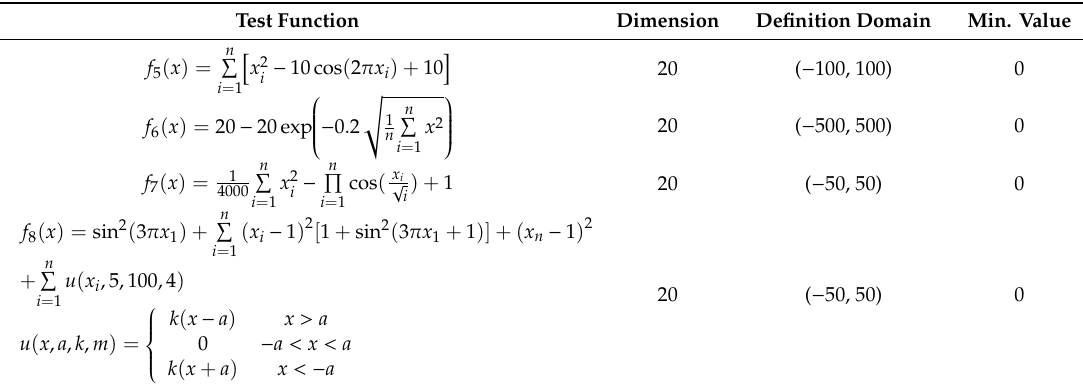
Table 7. Multimodal test